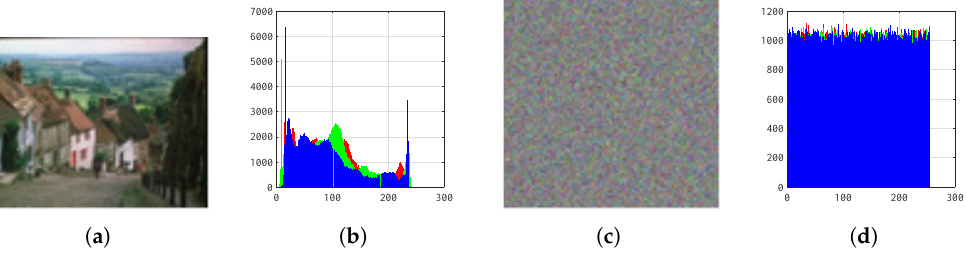
Figure 12. Histograms: ( a ) Goldhill image, ( b ) histogram of plain Goldhill, ( c ) encrypted Goldhill, and ( d ) histogram of encrypted Goldhill.